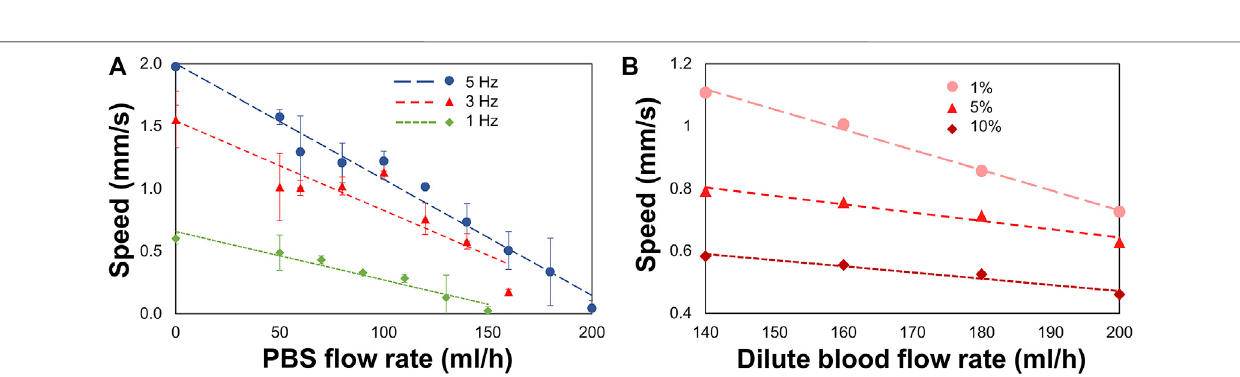
FIGURE5| MANiACspeedsagainst fl owratesinPBSanddilutedK2EDTA-treatedwholemouseblood. (A) MANiACsdemonstratedtranslationagainst fl owatlow rotationfrequencies(1 – 5 Hz).Lowerrotationfrequenciesresultinslightlylowerstall fl owrates( fl owrateatwhichMANiACvelocityfallstonearly0 mm/s).Rotationat5 Hz enabled MANiACs to translate (move) against fl ow of 180 ml/h. (B) Translation speeds of MANiACs (5 Hz) in 1, 5, and 10% mouse blood. Interestingly, translation in mouse blood is less dependent on fl ow rate, possibly because blood constituents allow for increased coupling between the surface of the fl uidic device and the